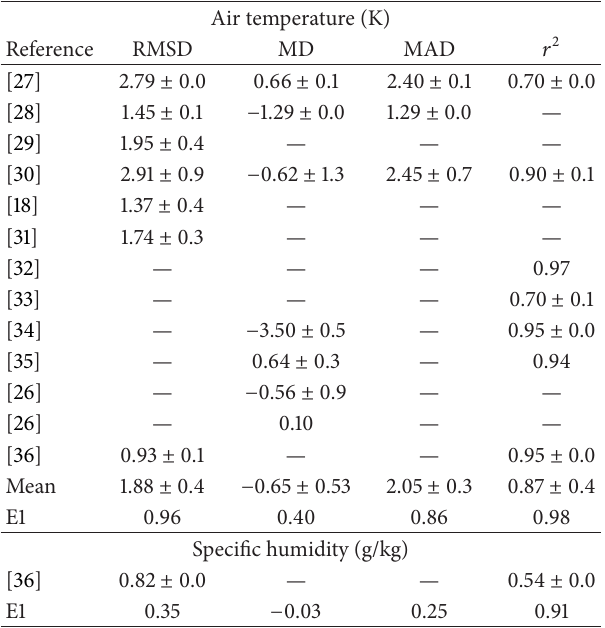
Table 11: Overview of deviations in air temperature and specific humidity between simulation and observation in other studies. For further explanations refer to Table